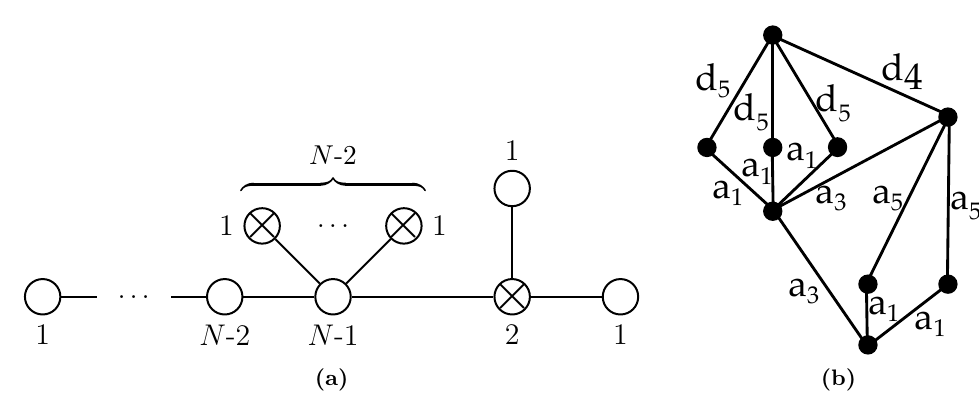
Figure 26 . (a) Magnetic quiver for the weakly coupled quiver description of T N and (b) Hasse diagram for [4] (cid:0) SU(3) 0 (cid:0) SU(2) (cid:0) [2].